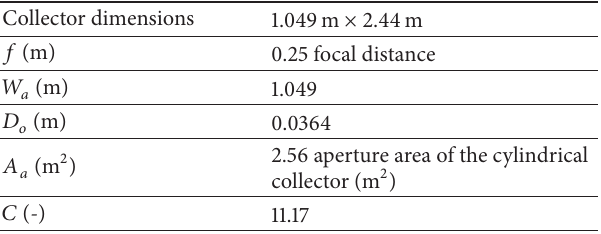
Table 3: Parameters of collector of Vidriales Escobar.